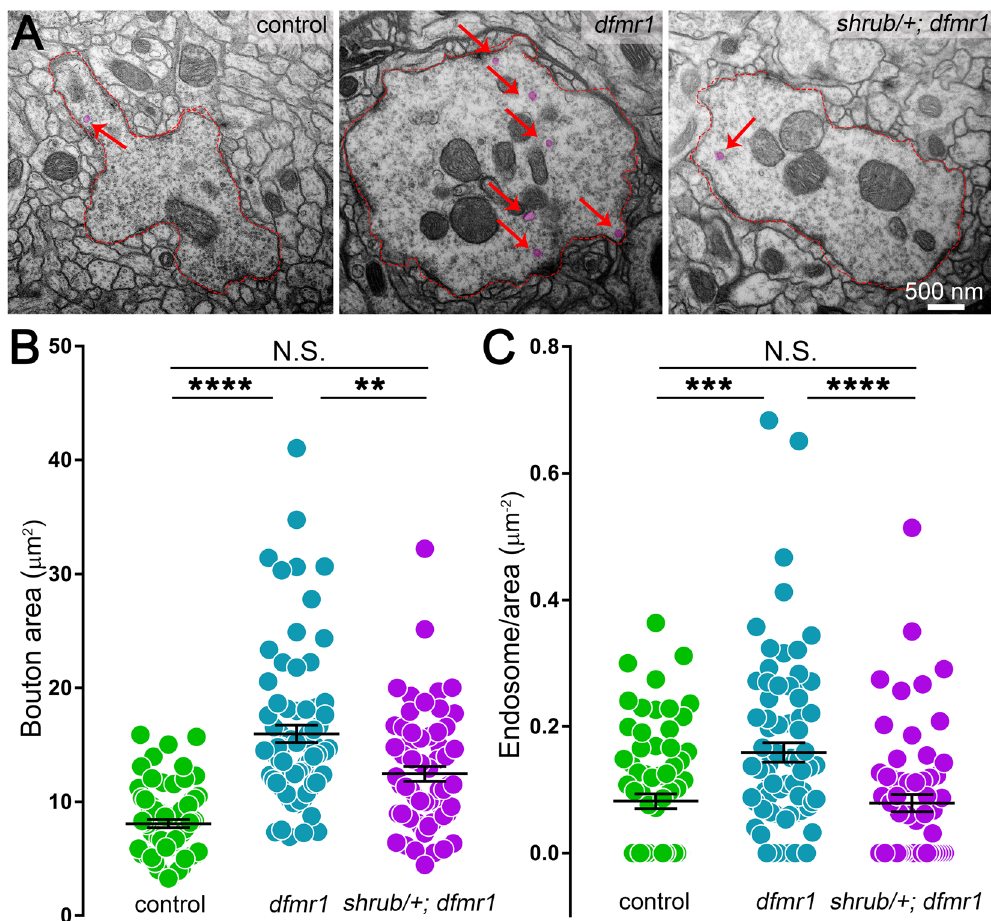
Figure 8. Shrub correction in dfmr1 prevents PN synaptic bouton ultrastructure defects. ( A ) Representative electron micrographs comparing synaptic PN ultrastructure between the transgenic control (Nrv3-Gal4/ + ), dfmr1 null mutant (Nrv3-Gal4, dfmr1 50M / dfmr1 50M ) and shrub 4 null heterozygote ( shrub 4 / + ) in dfmr1 homozygous null background ( shrub 4 / + ; Nrv3-Gal4, dfmr1 50M / dfmr1 50M ). Dotted red lines depict PN synaptic bouton borders and red arrows indicate endosomic vacuoles, pseudo-colored (magenta). Quantification as dot plot for ( B ) bouton area and ( C ) endosome number per bouton area for the above genotypes. Statistics done with one way ANOVA with the Kruskal-Wallis test followed by a Dunn’s multiple comparison test post hoc indicated as N.S. P > 0.05, * P < 0.05, ** P < 0.01, *** P < 0.001 and **** P <